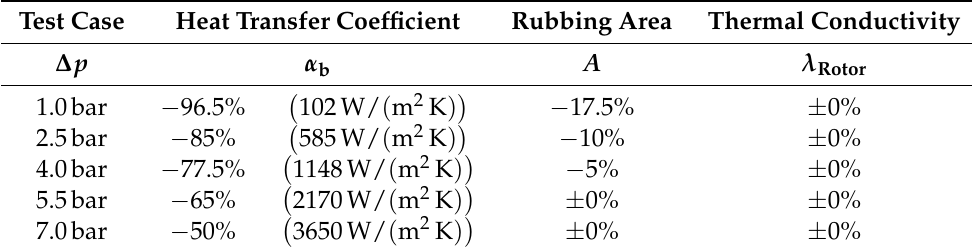
Table 2. Parameters of the numerical